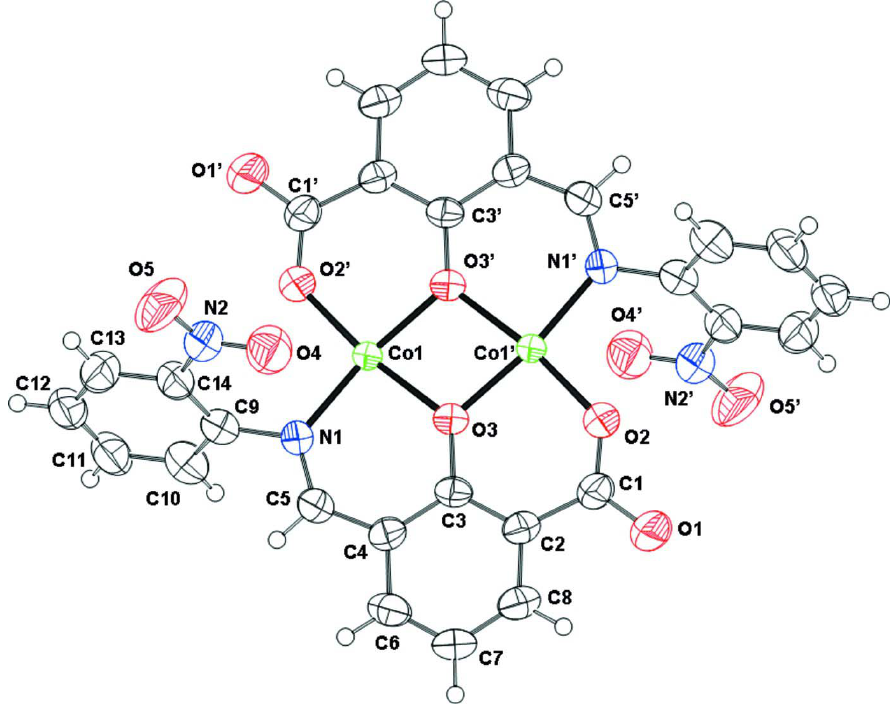
A view of the molecular structure of compound (I), showing the atom-labeling scheme. Atoms labeled (′) are generated by the symmetry code - x + 2, - y , - z +